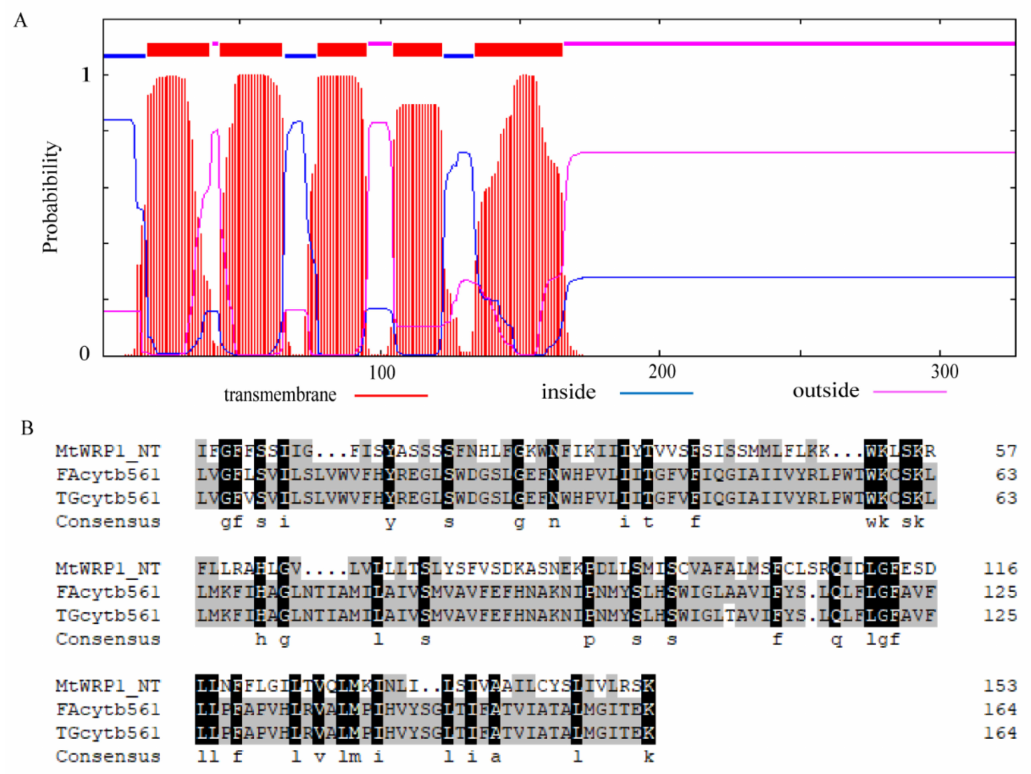
Figure 2. Structural analysis of TM domain at N-terminal MtWRP1: ( A ) Prediction of conserved TM domain in MtWRP1 as 5-passage transmembrane domain. ( B ) Sequence comparison of the TM domains of MtWRP1, FAcytb561 (XP_005049393.1), and TGcytb561